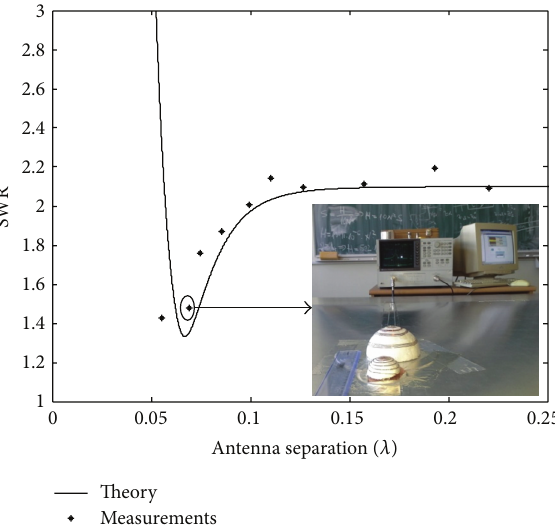
Figure 12: Comparison of measured and calculated SWR versus distance with a photo of measurement